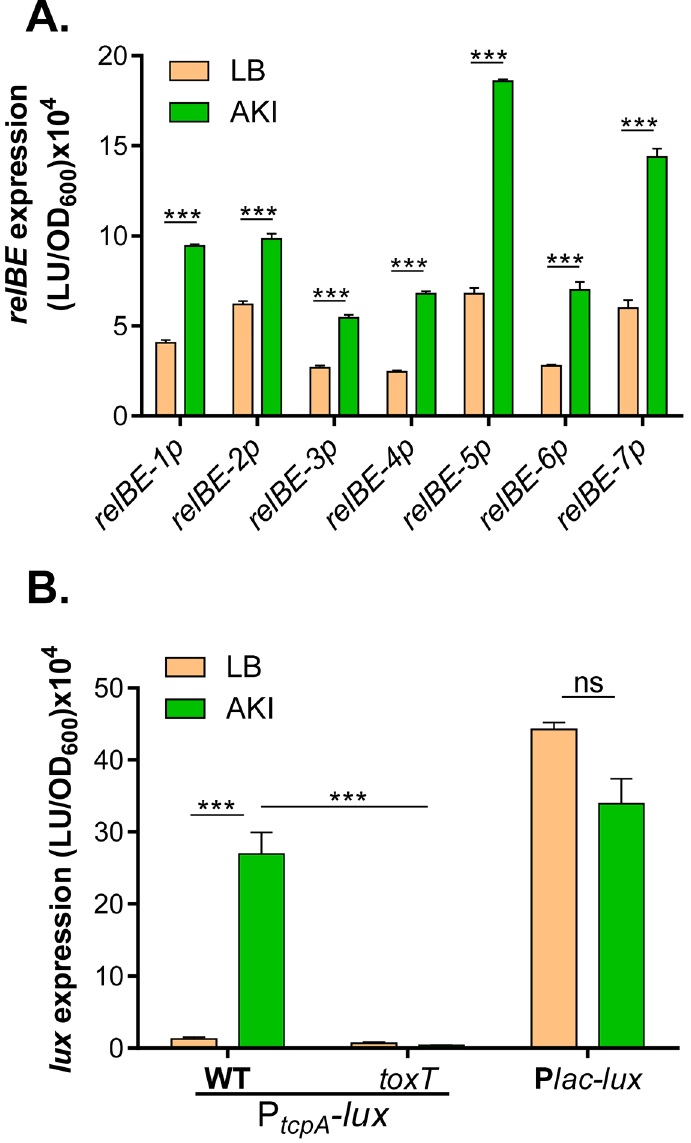
Fig 4. relBE expression under virulence inducing conditions. A. relBE-lux . Wild type strains containing each relBE-luxCDABE reporter plasmids were inoculated 1:1000 into LB or AKI medium and incubated at 37°C without shaking for 5 hrs. Luminescence was measured and normalized against OD 600 . Data are mean and s.d. of three independent experiments. *** : P < 0.001. B. P tcpA -lux and P lac-lux . Wild type or toxT mutant containing tcpA-luxCDABE reporter plasmids, or wild type containing P lac -luxCDABE reporter plasmids were inoculated 1:1000 into LB or AKI medium and incubated at 37°C for 5 hrs. Luminescence was measured and normalized against OD 600 . Data are mean and s.d. of three independent experiments. *** : P < 0.001. ns: no